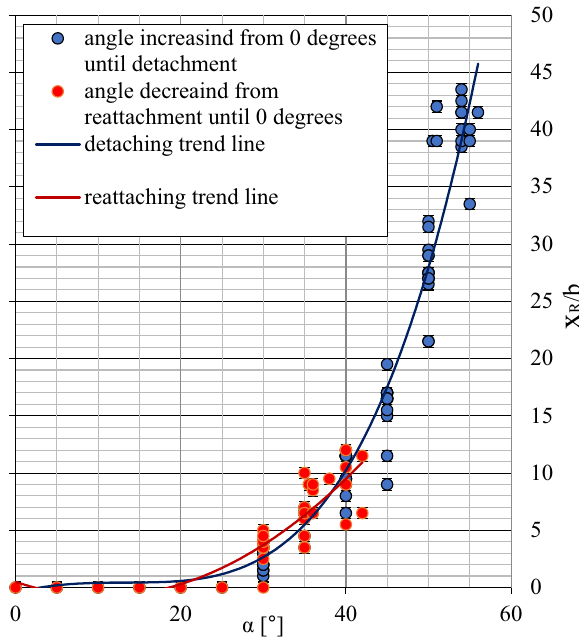
Figure 5. Reattachment distance x R for different directions of plate